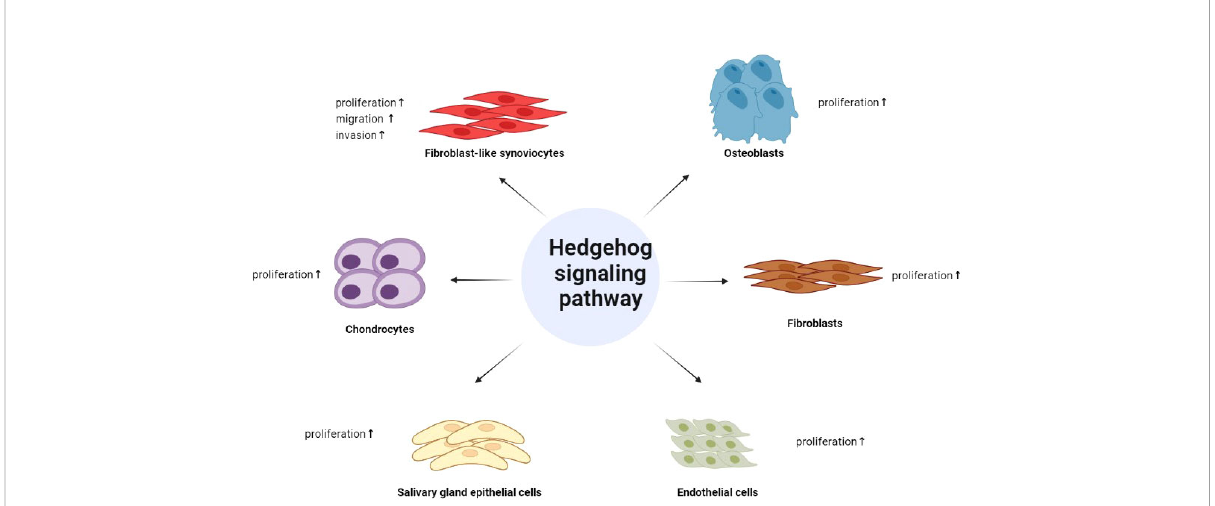
FIGURE 2 The role of Hedgehog signaling in rheumatic diseases. Hedgehog signaling pathway is involved in the in fl ammatory proliferation of FLSs, the differentiation and proliferation of chondrocytes, osteoblasts, and fi broblasts, and can stimulate the proliferation of endothelial cells and salivary gland epithelial